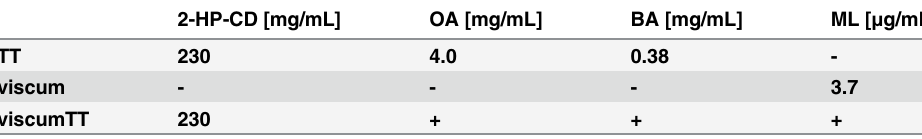
Table 1. Viscum album L.